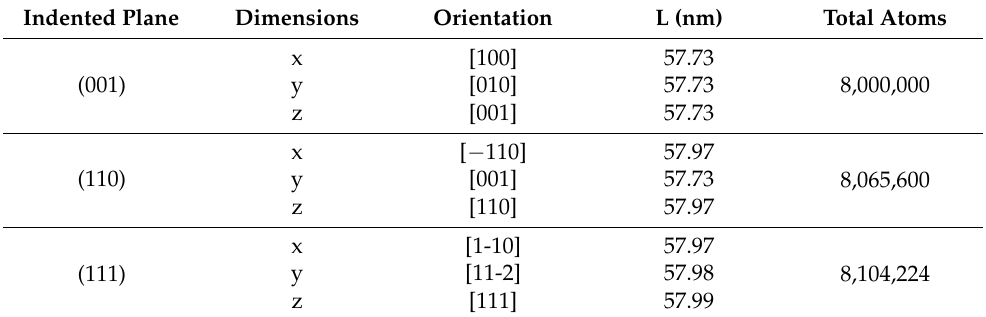
Figure 1. Schematic of indentation simulation setup and the crystal cell along the selected crystal directions. Table 1. The indented planes, dimensions, and numbers of atoms for the simulated ZnSe nano film models in this work.